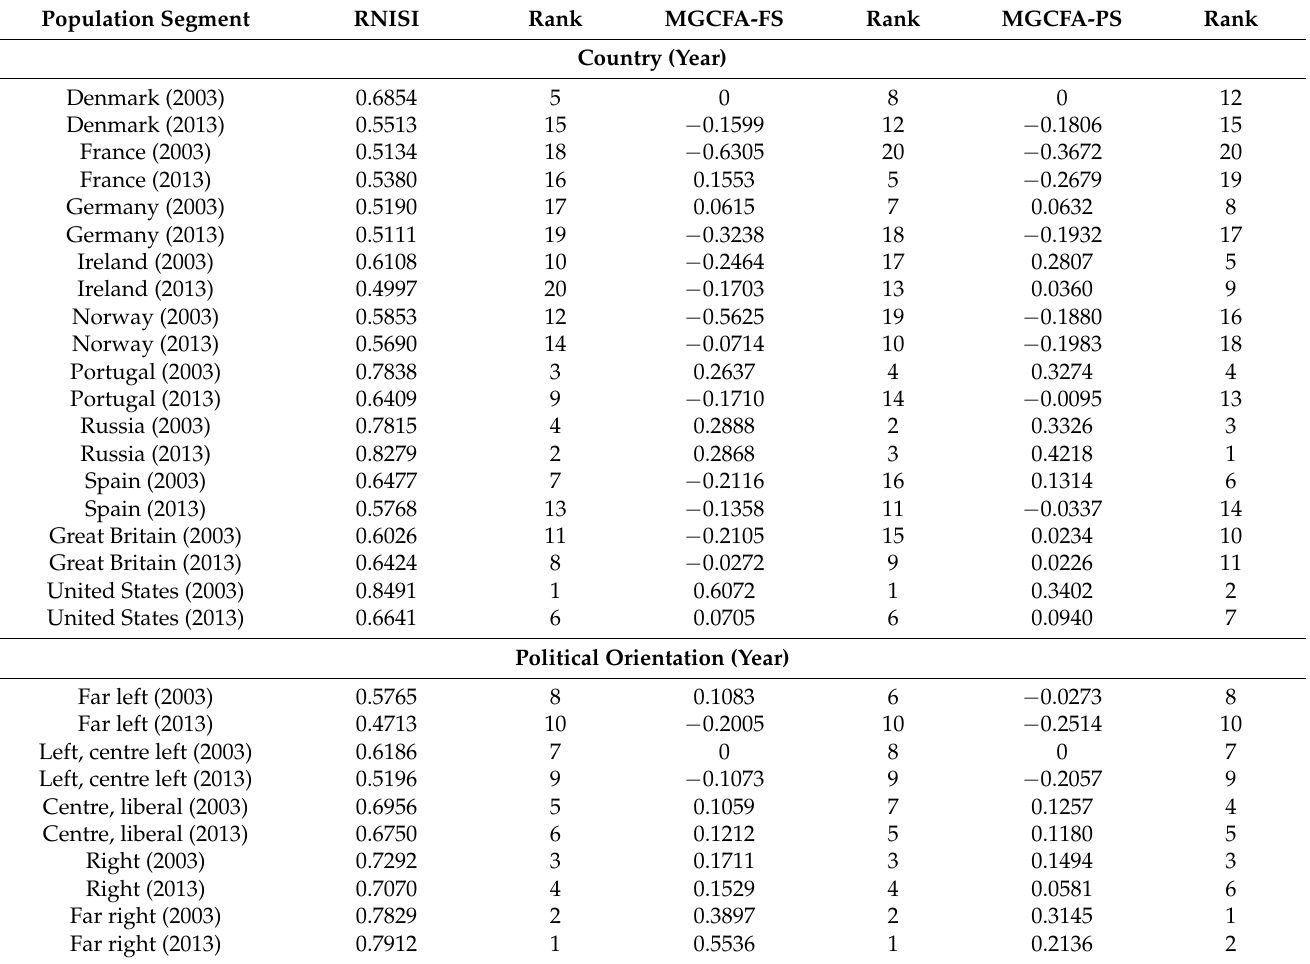
Table 4. Relative national identity synthetic indicators (RNISI), MGCFA-FS, MGCFA-PS.